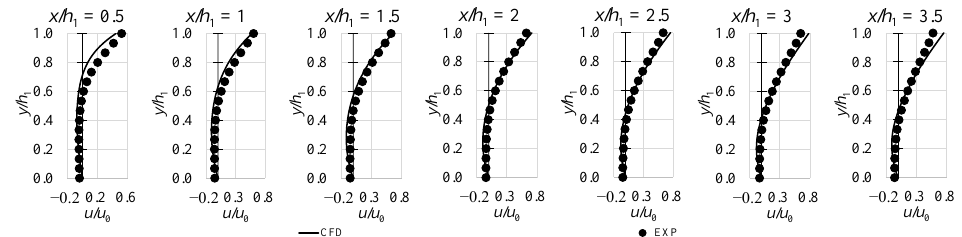
Figure 4. Numerically and experimentally obtained velocity u profiles at Re = 100.